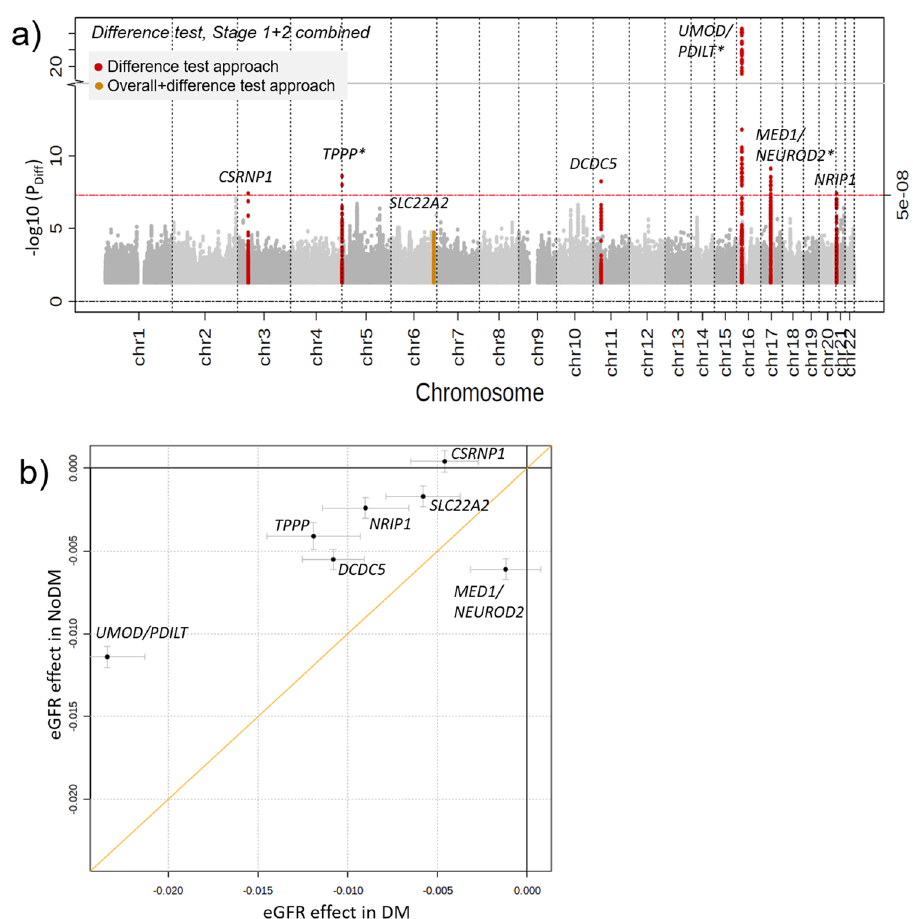
Fig. 2 Seven eGFR loci with differential effects by diabetes status. We searched for DM/noDM-differential genetic associations on eGFR using the difference test approach and the overall + difference approach in combined stage 1 + 2 (CKDGen, UKB, MVP, MGI, and HUNT; n DM = 178,691; total n noDM = 1,296,113). Seven difference loci were identi fi ed. a Shown are difference test P -values over chromosomal base position (Manhattan plot) highlighting the six loci identi fi ed by the difference test approach (red, P Diff < 5 × 10 − 8 ) and the one locus identi fi ed by the overall + difference test approach (orange, 610 variants 16 with stage 1 P Overall < 5 × 10 − 8 , P Diff < 0.05/610 = 8.2 × 10 − 5 ). Loci are annotated by the name(s) of the nearest gene(s); asterix indicates loci that were also identi fi ed by the discovery + replication design (Table 1, Supplementary Fig. 1). b Shown is a comparison of DM-/noDM-speci fi c eGFR-effect sizes for the seven identi fi ed difference lead variants based on combined stage 1 + 2 data. Effect sizes are aligned to the eGFR-decreasing alleles in noDM except for CSRNP1 (aligned to eGFR-decreasing allele in DM). Error bars re fl ect 95% con fi dence intervals of the estimated genetic genome-wide signi fi cant associations ( P < 5 × 10 − 8 , Supplemen- tary Data 9), particularly for hypertension and blood counts: for 3 of the 11 variants, the eGFR-decreasing alleles were associated with increased risk of hypertension (near UMOD/PDILT , DCDC5, and PIK3CG ). The variant rs55722796 near MED1/ NEUROD2 , solely associated with eGFR in noDM individuals, was not associated with hypertension, but the eGFR-decreasing allele (in noDM) was associated with decreased blood counts (i.e.,